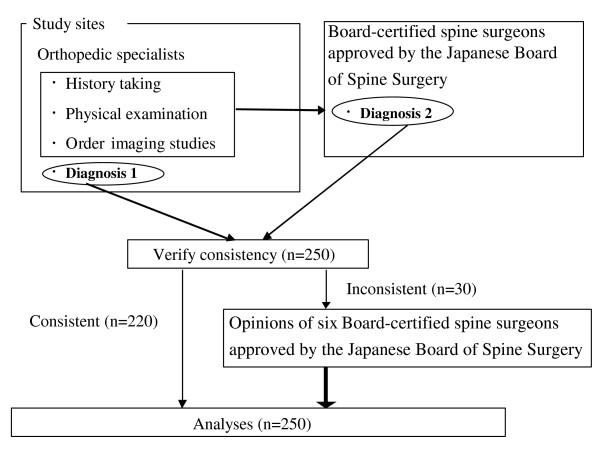
Flow chart of how the diagnosis of LSS was determined.